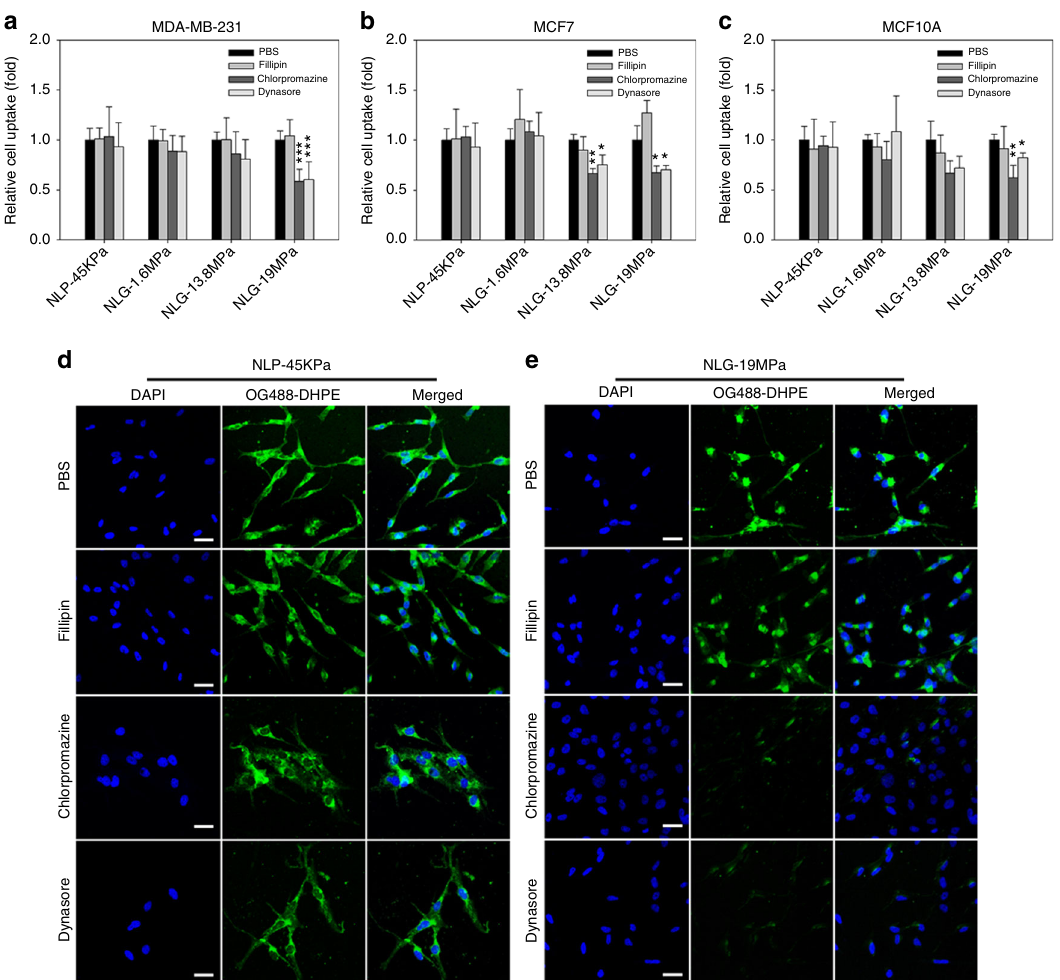
Fig. 4 Particle elasticity mediates cellular uptake via different internalization pathways. Relative cellular uptake of NLP and NLGs in MDA-MB-231 ( a ), MCF7 ( b ), and MCF10A ( c ) cells in the presence of small molecules inhibiting clathrin (Chlorpromazine), caveolae (Filipin) and both endocytic pathways (Dynasore). Representative fl uorescent microscope images of cellular uptake of soft NLP-45KPa ( d ) and hard NLG-19MPa ( e ) in response to endocytosis inhibitors. The scale bars represent 50 μ m. * P < 0.05, ** P < 0.01, *** P < 0.001. The mean values and error bars are de fi ned as mean and S.D.,